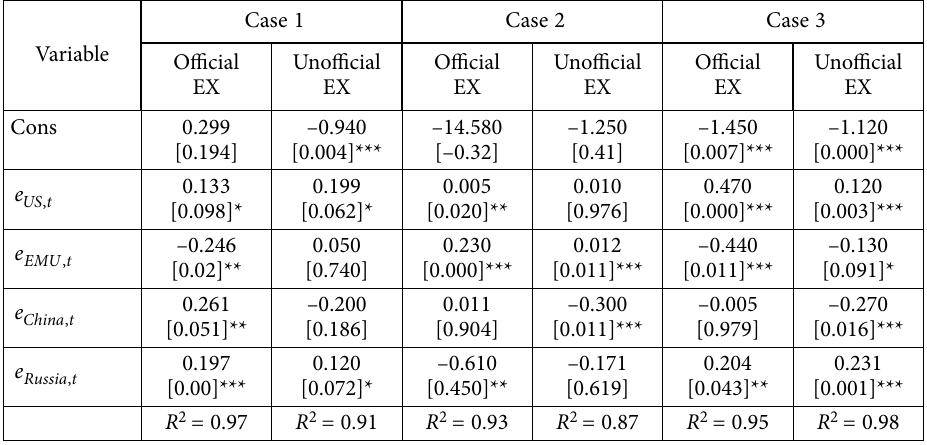
Table 3. Empirical results of basket currencies model Eq. (9) (source: own research)